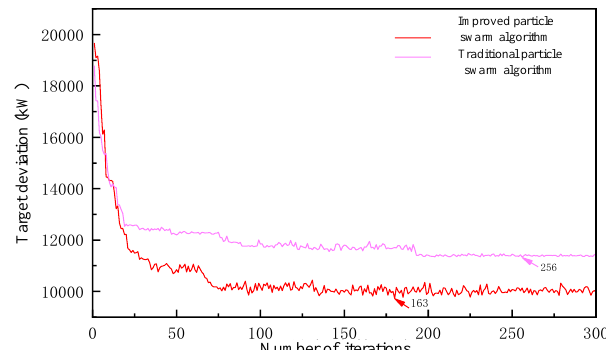
Figure 9. Comparison of algorithm convergence.